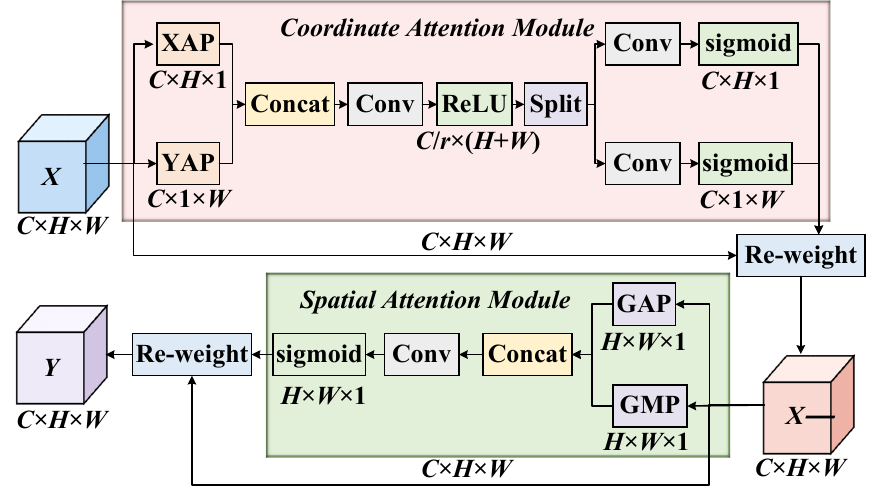
Figure 3. Algorithm flow chart of a HDAU.